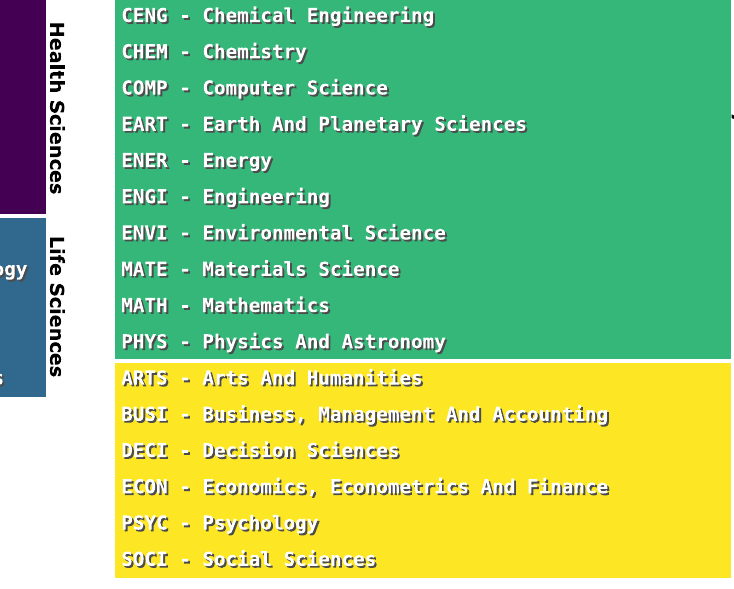
Fig 1. Scopus’ intermediate classification. List of intermediate classifications for journal labeling according to Scopus, grouped by macro area.